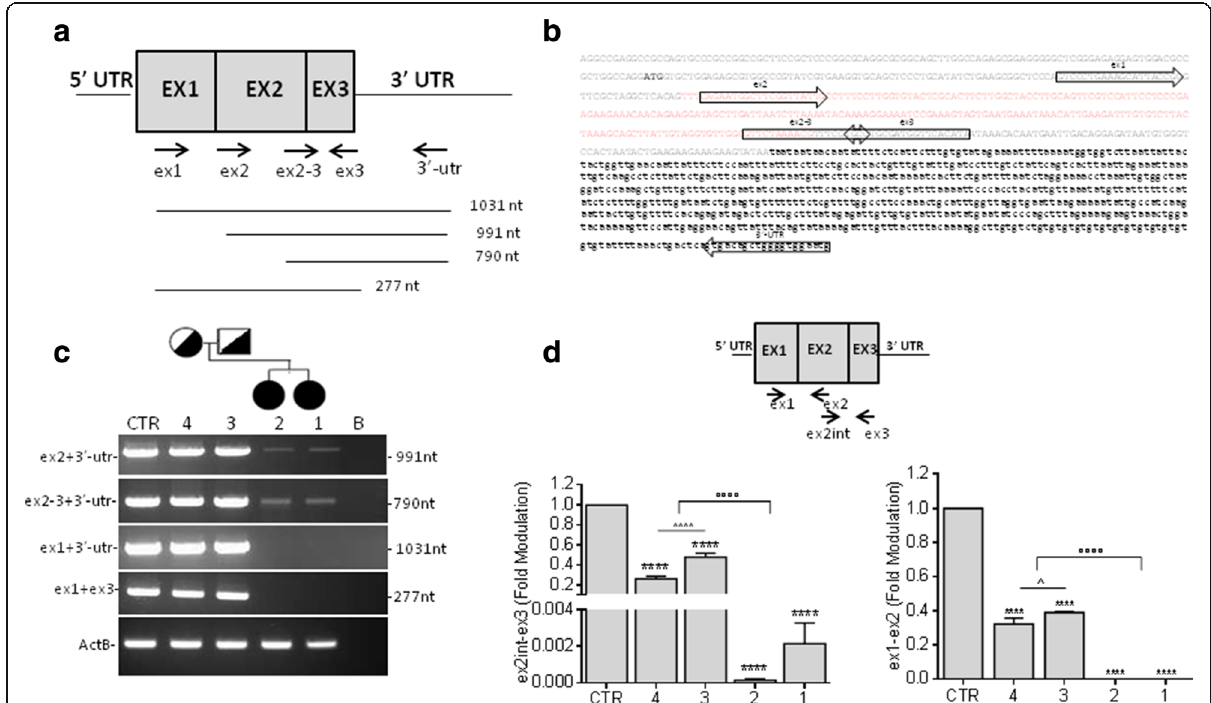
Fig. 1 Molecular characterization of the homozygous and heterozygous CISD2 transcript. a A schematic representation of the CISD2 transcript: the arrows represent the PCR primers, and four overlapping sets of CISD2 primers were used. The lines indicate the expected sizes of the PCR products using the specific set of primers. b The nucleotide sequence of CISD2 cDNA with exons in uppercase letters and alternate colours, the 5 ′ -UTR and 3 ′ -UTR in lowercase letters, and the ATG in bold letters. The arrows indicate the PCR primers used for the characterization of the CISD2 transcript. c RT-PCR analysis performed on PBMCs derived from a healthy individual (CTR), homozygous probands (1 and 2) and heterozygous unaffected parents (3 and 4). ActB was used as a loading control, and a negative PCR control ( b ) was included to test possible contamination. The data indicate a putative skipping of the N-terminus of CISD2 in patients and suggest a strong instability of mutant CISD2 mRNA. d mRNA quantitative real-time PCR. A schematic representation of the CISD2 transcript shows the PCR primers used for the analysis. The CISD2 mRNA level drastically decreased in the homozygous samples, compared to that in the healthy PBMCs. The histograms show values normalized relative to a housekeeping gene ( ActB ) and expressed as a fold modulation compared to the healthy control. The error bars represent the mean±SEM for three experiments. Ordinary one-way ANOVA, *P<0,05, **P<0,01, ***P <0,001 and